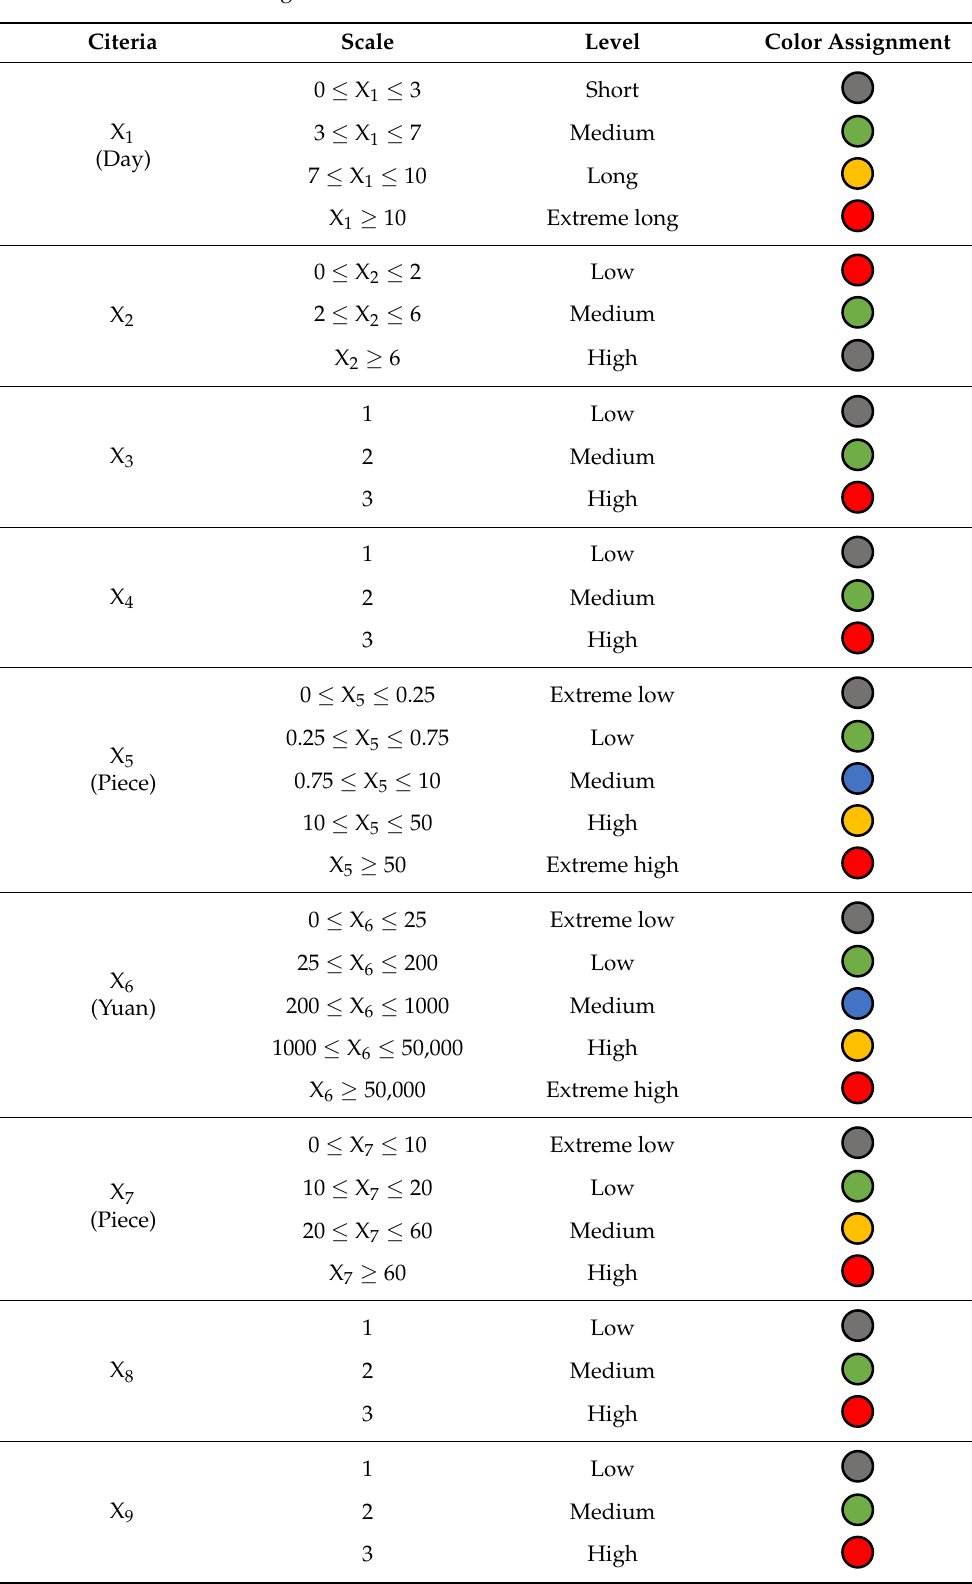
Table 3. Level and color assignment of variables.